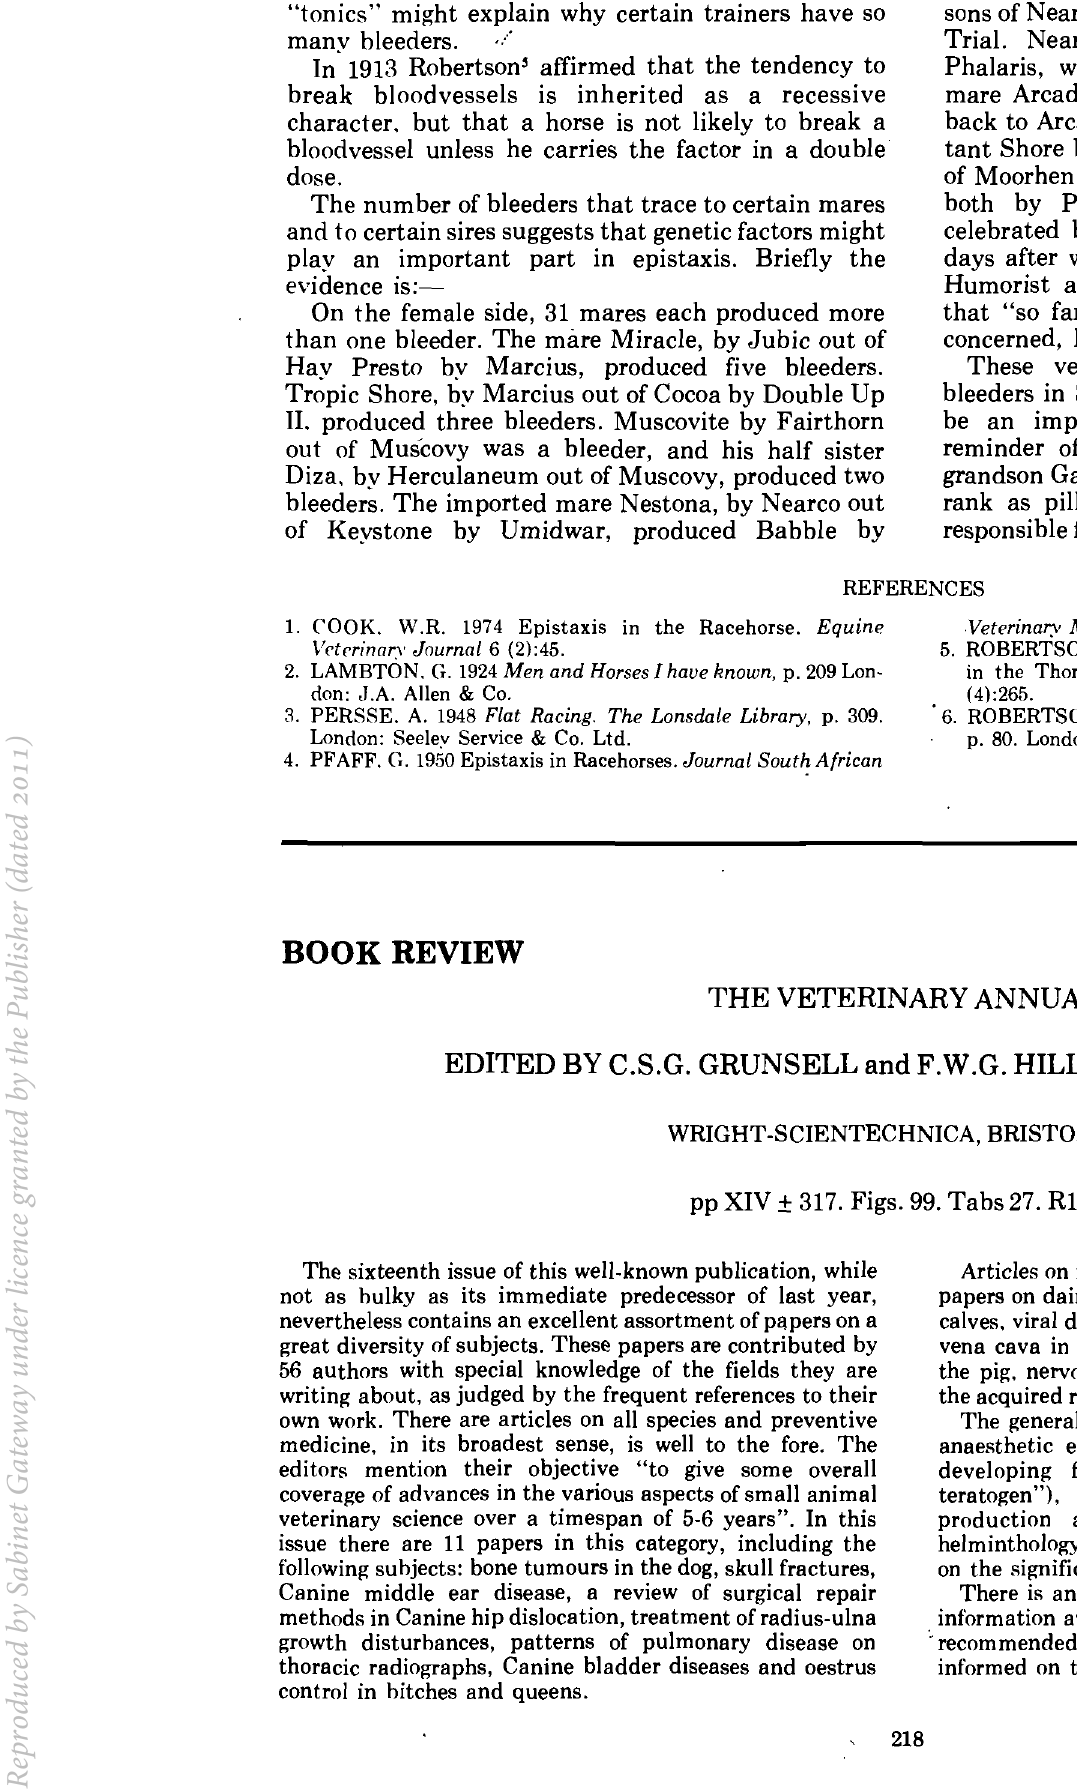
informed on the latest